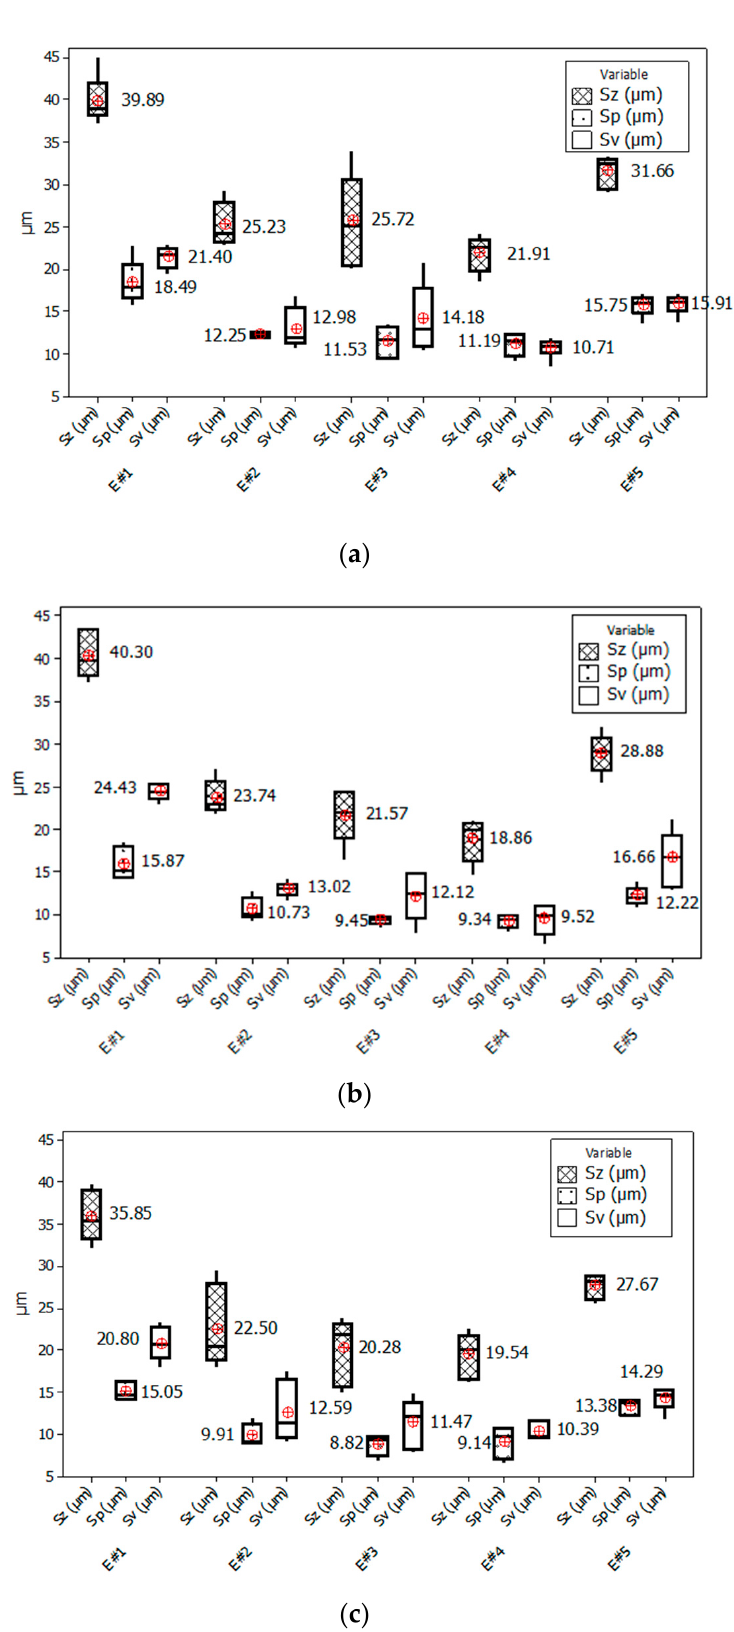
Figure 7. Centre and spread of Sz , Sp and Sv parameters for three milling strategies: S#1 ( a ), S#2 ( b ) and S#3 ( c ). The box plot presents the mean, the median, the interquartile range box and the range of the data. E#1, E#2, E#3, E#4 and E#5 are names of measurement